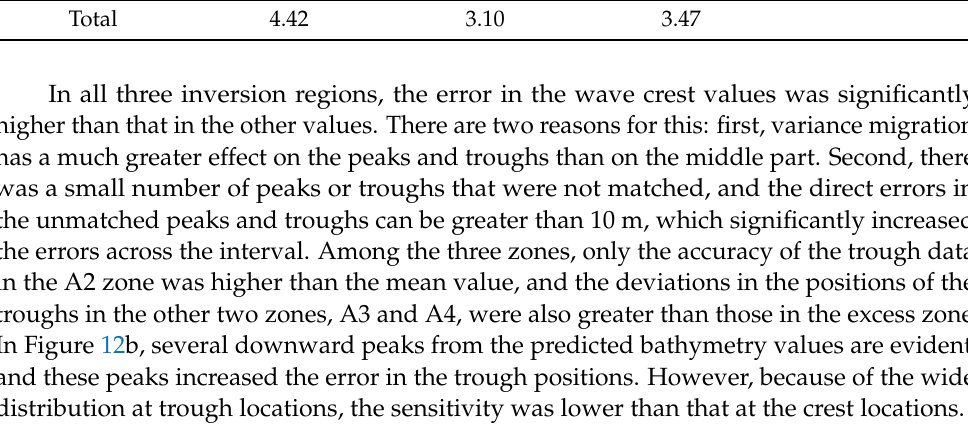
Table 3. Error analysis for different depths in the three regions. Inversion Region